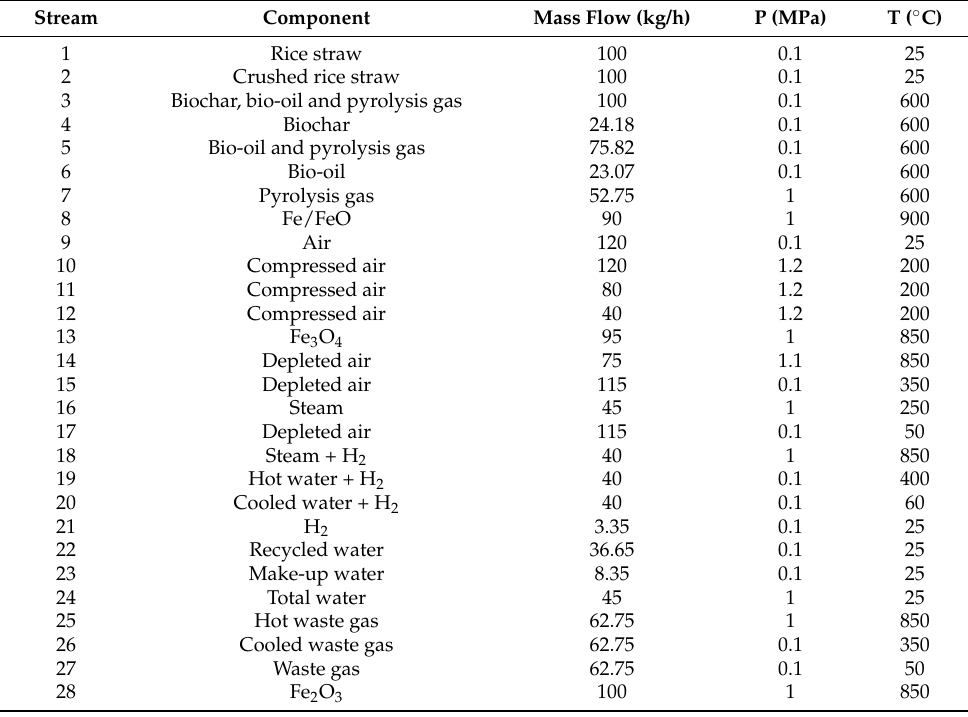
Table 2. Stream and electricity results of the proposed